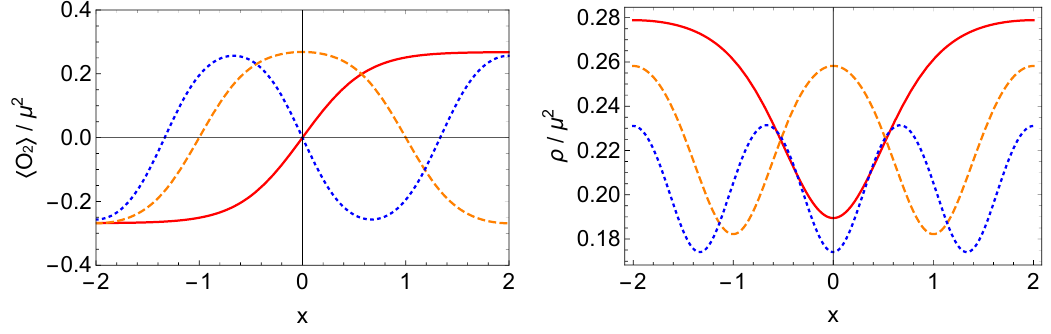
Figure 5 . The condensate (left) and the charge density (right) pro(cid:12)les obtained from each bulk solution for (cid:22) = 6 : 5 (solid line), (cid:22) = 7 : 5 (dashed line), and (cid:22) = 8 : 5 (dotted line),